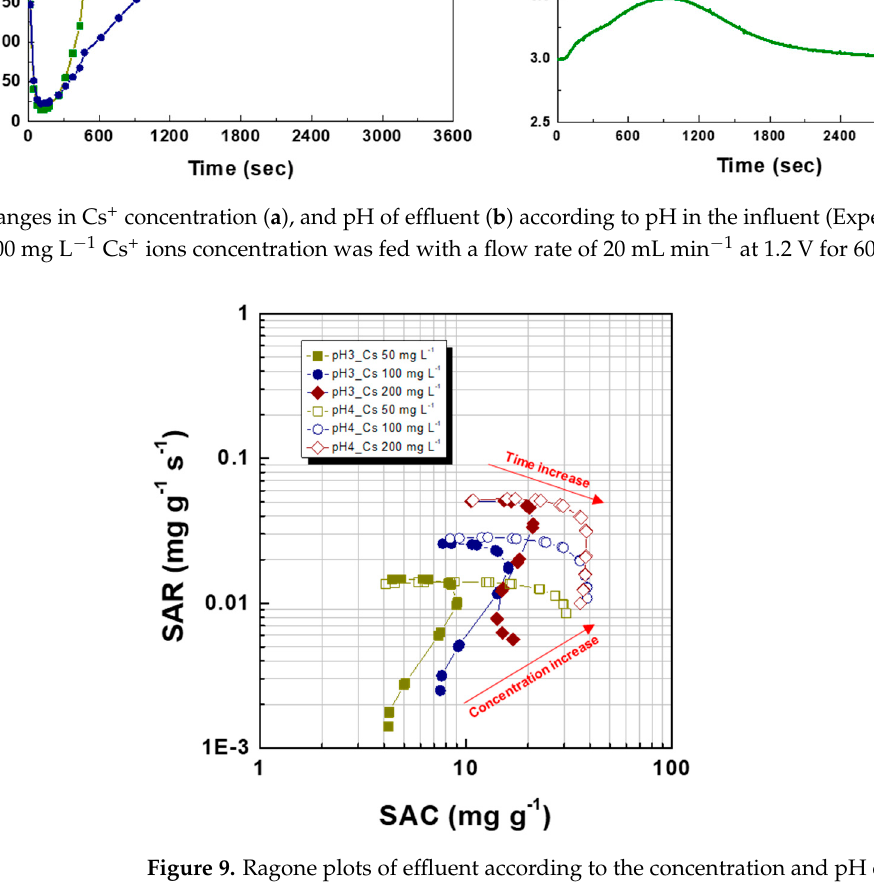
Figure 9. Ragone plots of effluent according to the concentration and pH of Cs + ions in the influent (Experimental conditions: Influent of pH 3 or pH 4 was fed with a flow rate of 20 mL min − 1 ).